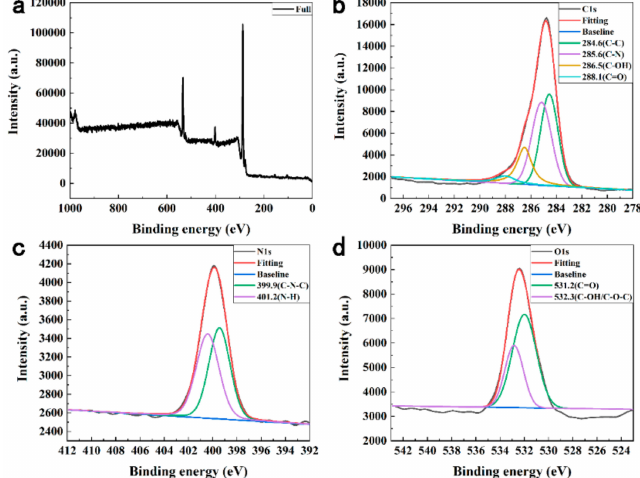
Figure 3. ( a ) XPS full spectrum of N-CDs. ( b )–( d ): High-resolution C1s, O1s and N1s peaks of the N-CDs,